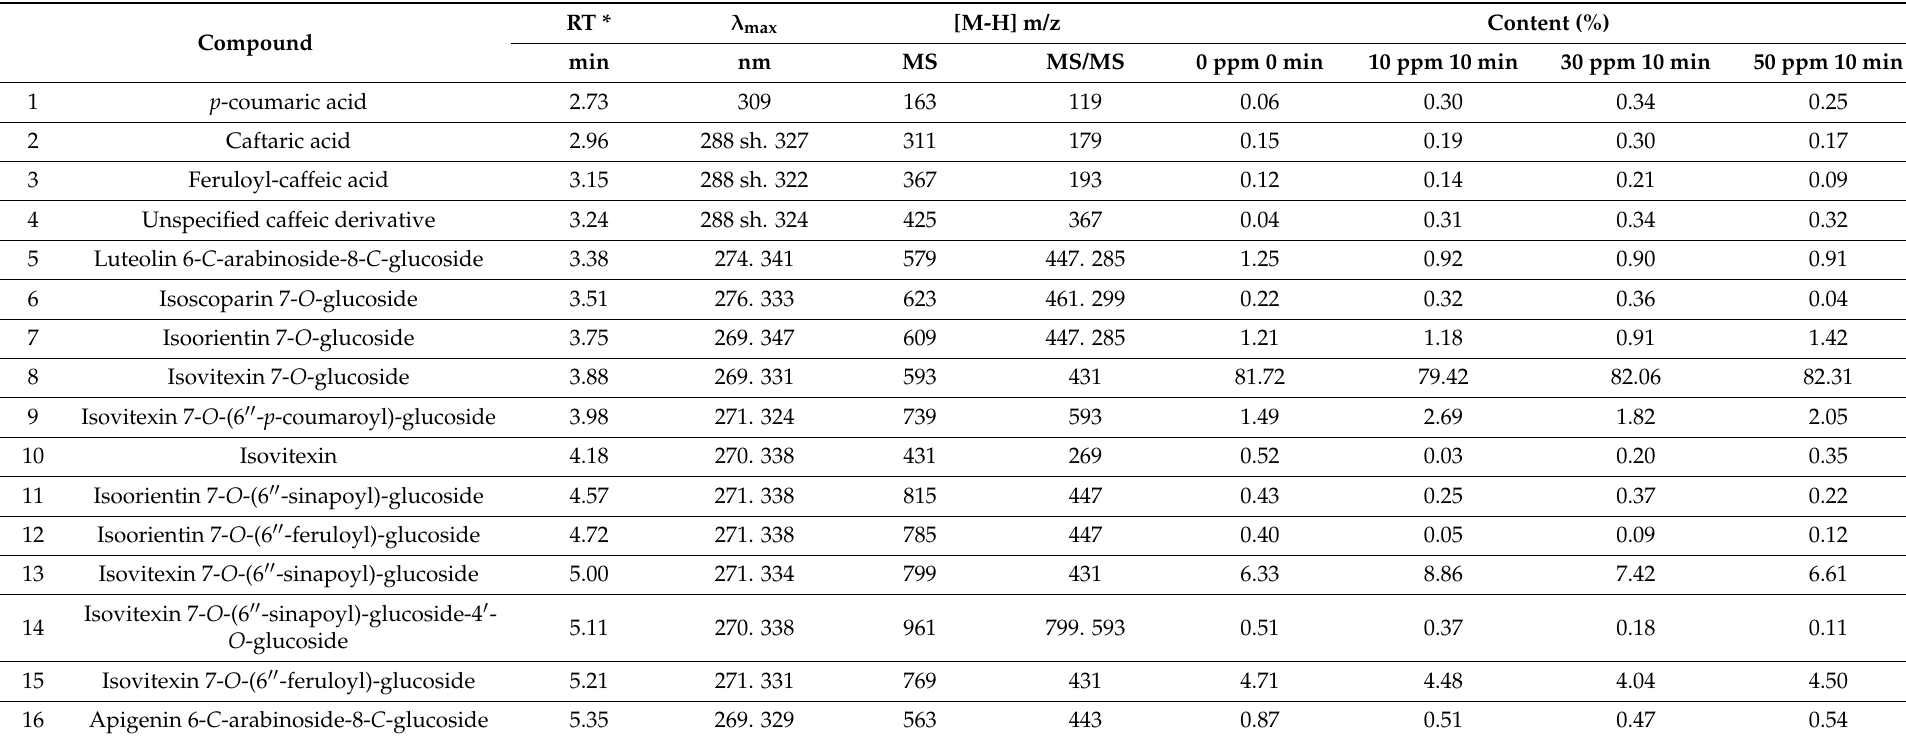
Table 1. Individual phenolic compounds identified by UPLC-PDA-MS/MS in barley young